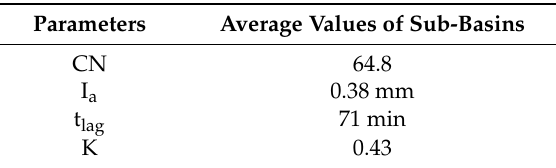
Figure 9. Observed and simulated hydrographs of the 1990s. Table 6. Calibrated parameters of the 2000s.